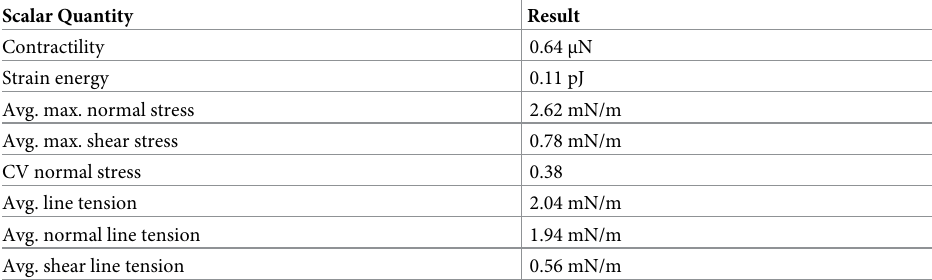
Table 1. Scalar values computed by pyTFM quantifying cellular force generation and stress